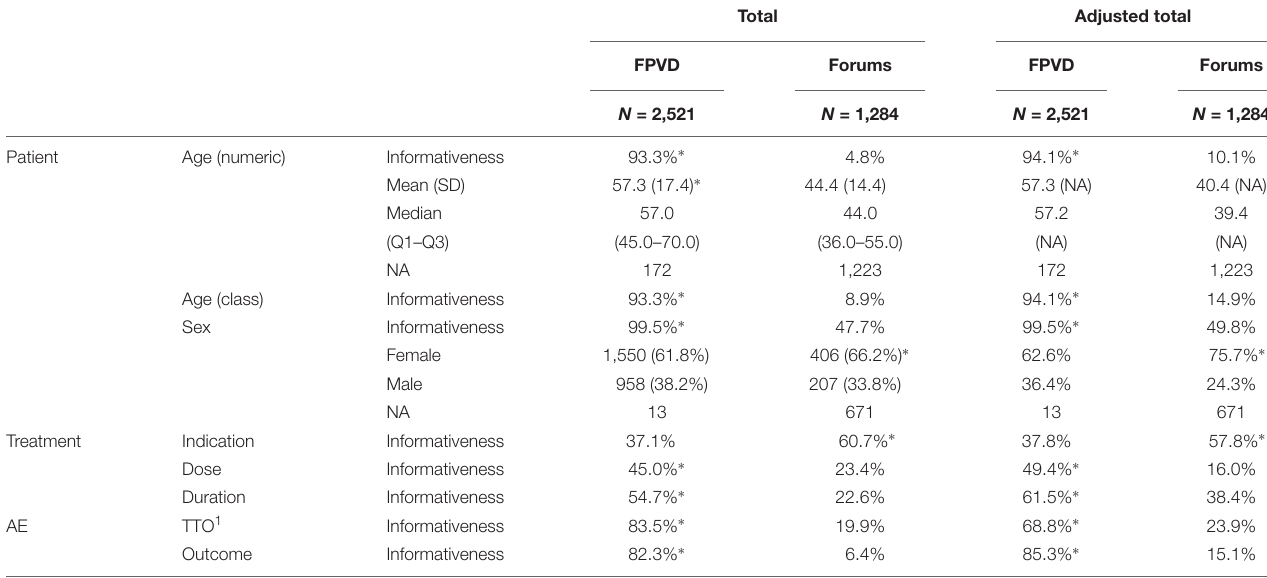
TABLE 4 | Comparison of the age and sex of patients and informativeness of the